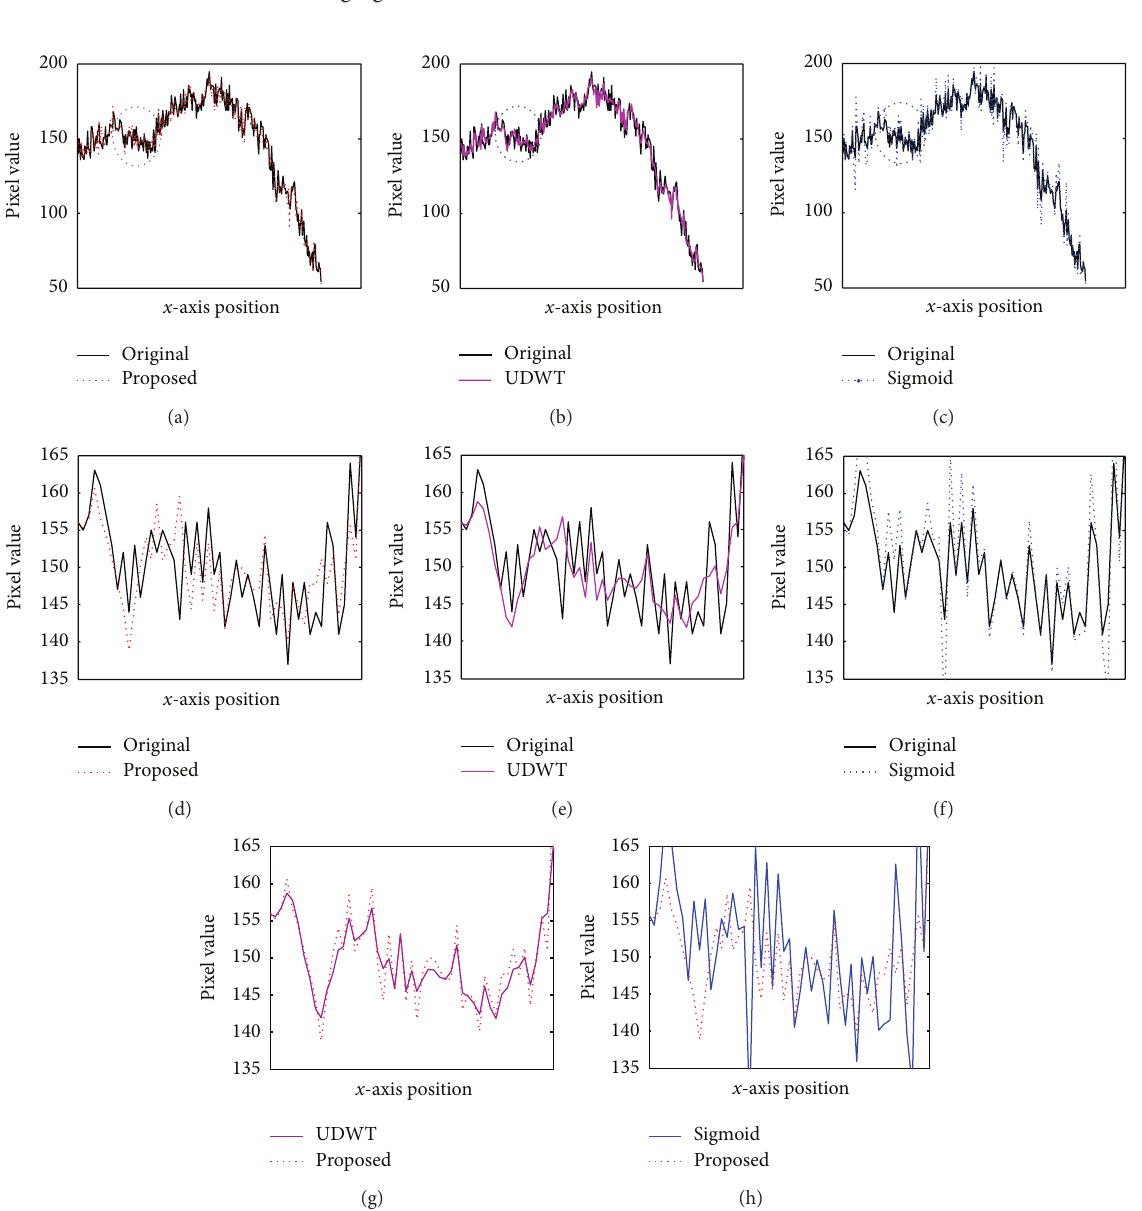
Figure 4: An example showing pixel-value profiles from original and processed mammograms. (a)–(c) Original versus processed by the proposed method, the modified UDWT method, and the sigmoid-type wavelet coefficient mapping method, respectively. The profiles were measured along the horizontal lines (black lines) as shown in Figures 3(a)–3(c). (d)–(f) Corresponding magnified profiles indicated by circles as shown in (a)–(c), respectively. (g) Profiles of two processed images; the solid line indicates the profile of an image processed by the modified UDWT method, and the dotted line indicates that by the proposed method. (h) Profiles of two processed images; the solid line indicates the profile of an image processed by the sigmoid-type wavelet coefficient mapping method, and the dotted line indicates that by the proposed